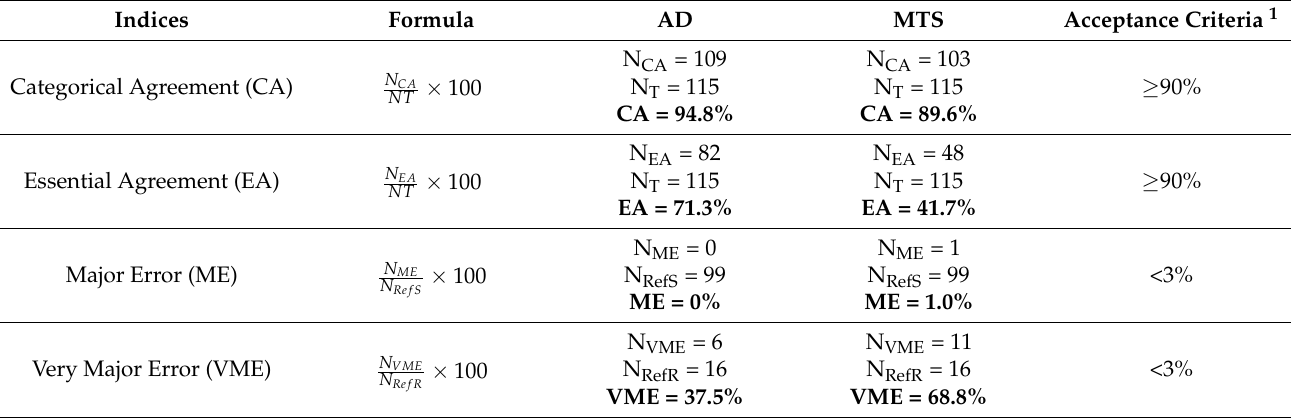
Table 1. Agreement and error indices for agar dilution and MIC test strip methods in comparison with broth microdilution. Indices Formula AD MTS Acceptance Criteria